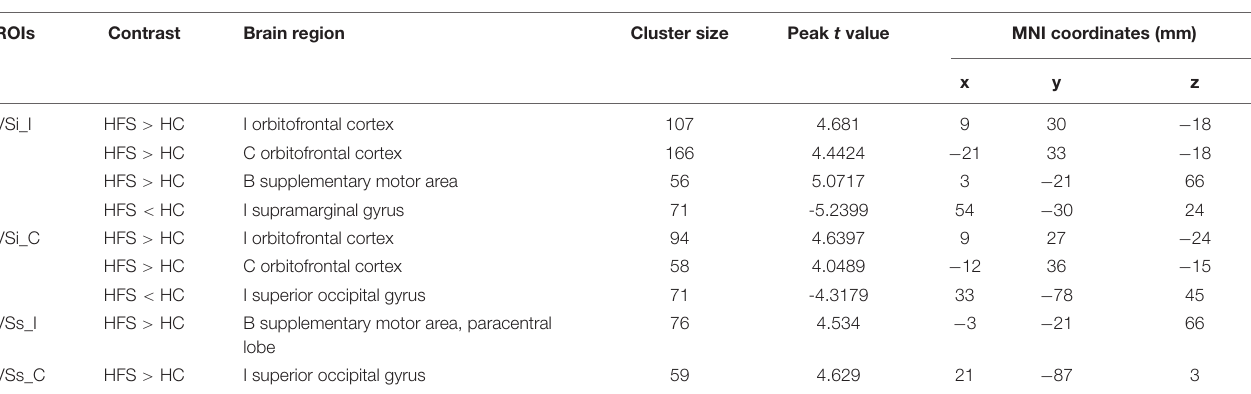
FC, functional connectivity; ROIs, regions of interest; C, contralateral; DCP, dorsal caudal putamen; DRP, dorsal rostral putamen; DC, dorsal caudate; HFS, hemifacial spasm; HC, healthy control; MNI, Montreal Neurological Institute. TABLE 3 | Altered FC in the ventral striatum ROIs between two